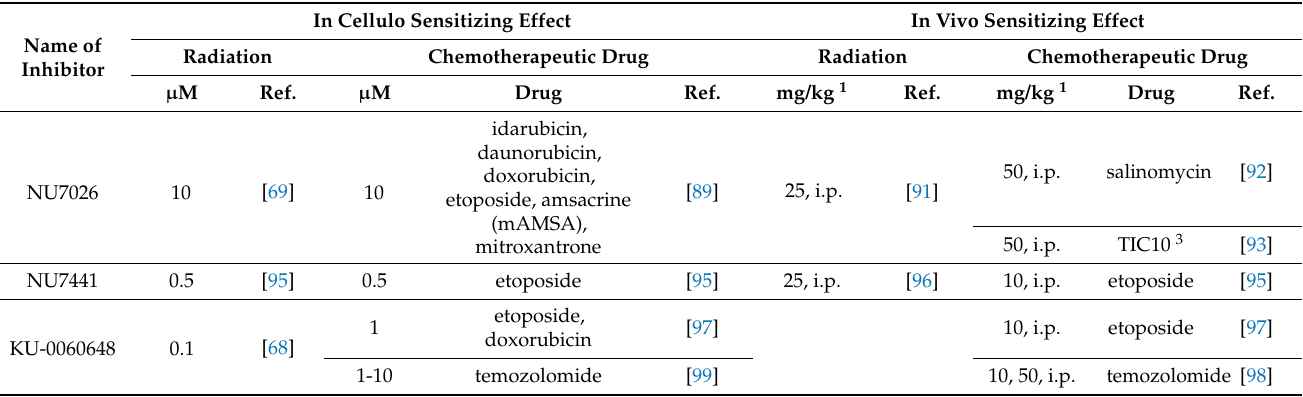
Table 3. In cellulo and in vivo radio- or chemo-sensitizing effects of DNA-PK